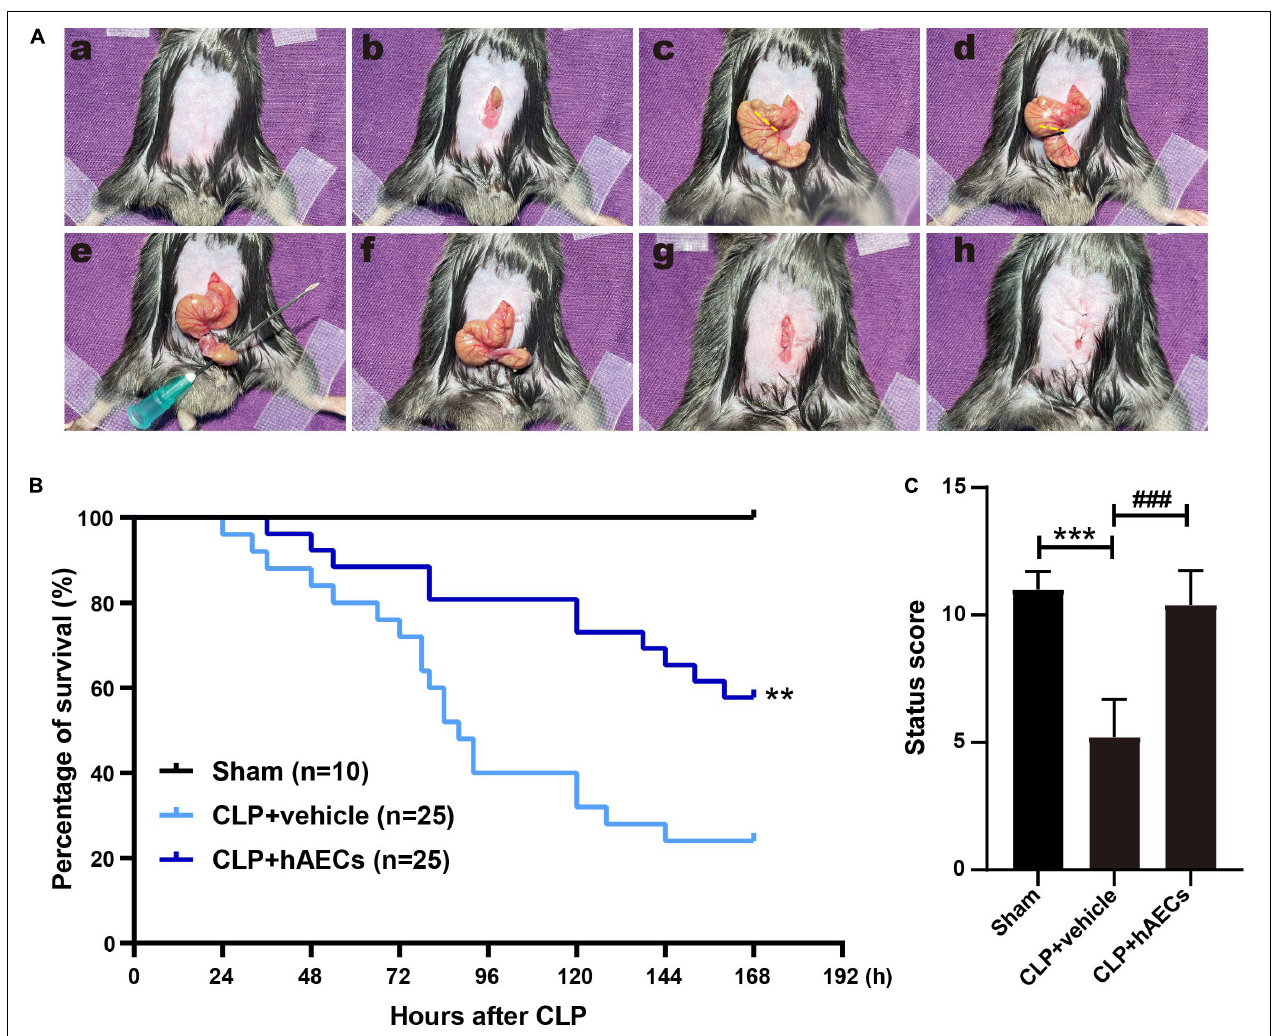
FIGURE 1 | Establishment of septic mouse model and the effects of human amnion epithelial cells (hAECs) on cecal ligation and puncture (CLP) mice. (A) Critical steps in the CLP operation in mice. First, the abdominal area was disinfected after shaving (a), the midline skin was incised (b), and the cecum was exposed (c). High-grade sepsis was induced by ligation of 75% of the cecum (d). Then, cecal puncture (through and through) was performed using 21-gauge needle (e). After removing the needle (f), the wound was closed (g) and the abdominal skin was sutured (h). (B) Survival rate after induction of sepsis by CLP in mice. ** P < 0.01 vs. the CLP + vehicle group. (C) Assessment of the clinical signs of mice 16 h after CLP. *** P < 0.001 vs. the sham group, ### P < 0.001 vs. the CLP + vehicle